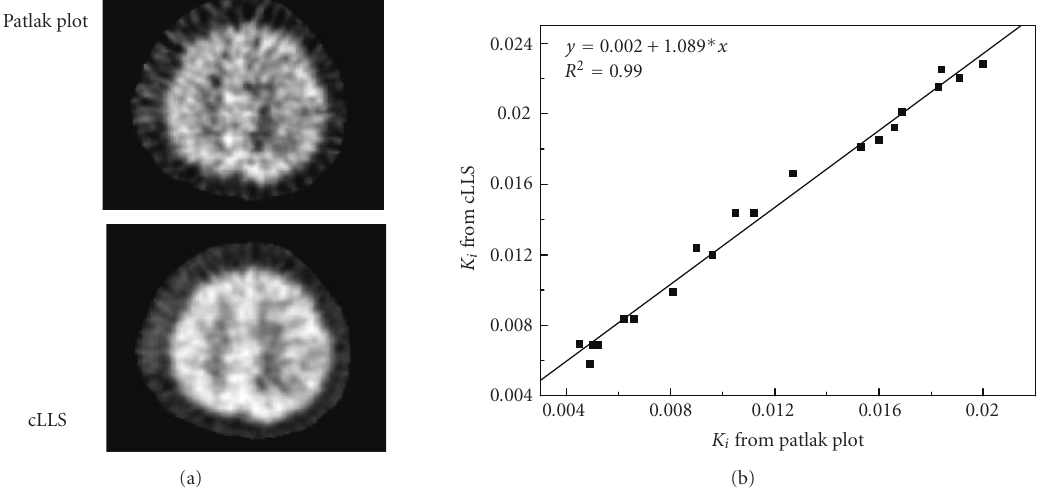
Figure 5: The correlation of the parameter comparison between cLLS and Patlak methods in parametric image space.